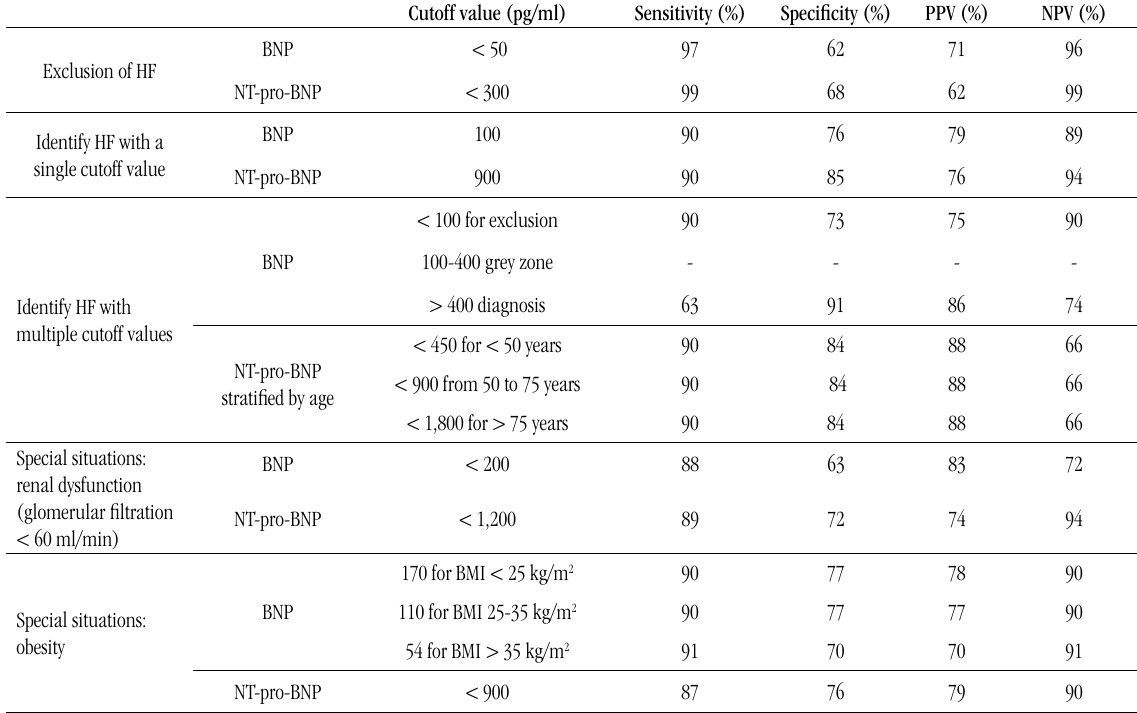
tABLE 4 – Recommended BNP and NT-pro-BNP cutoff values for the diagnosis of